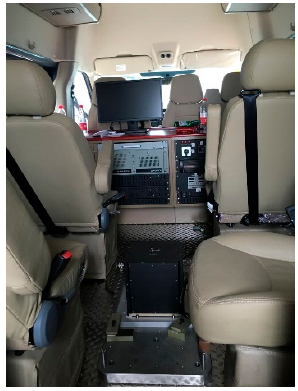
Figure 12. The RINS in navigation experiment vehicle.